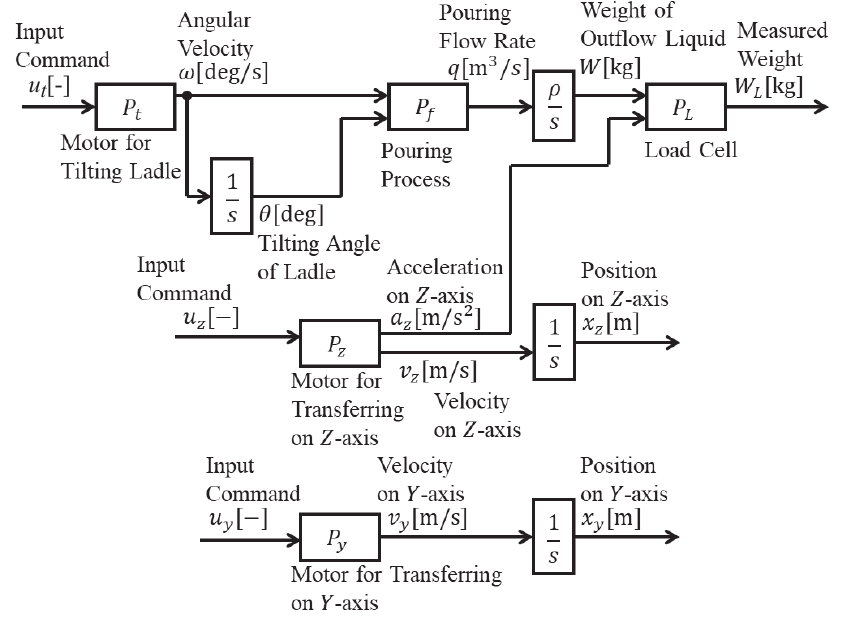
Figure 2. Block diagram of motorized pouring